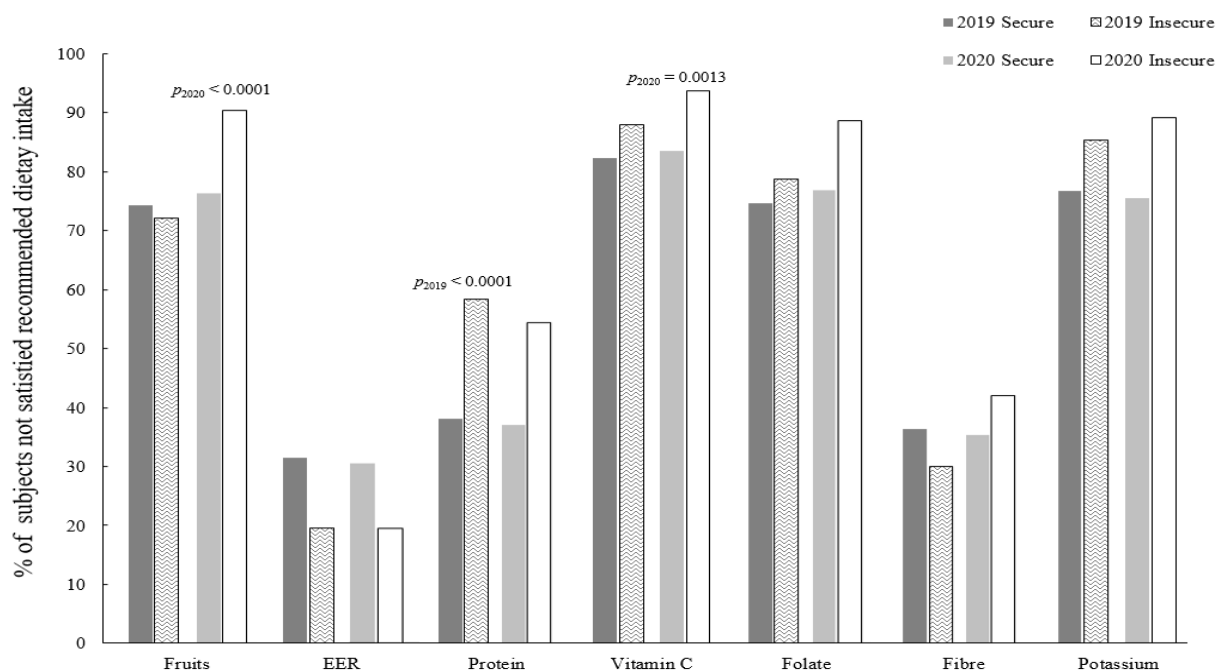
Figure 1. Distribution of the study population that did not meet the recommended Dietary Reference Intakes of selected food and nutrients for Koreans according to food security level. EER; Estimated Energy Requirement. All statistical analyses were performed taking into account the effect of the complex sampling design and weight. p values were from Rao-Scott chi-squared tests. p 2019 was from the comparison for dietary intake data in 2019 between food secure and insecure group,